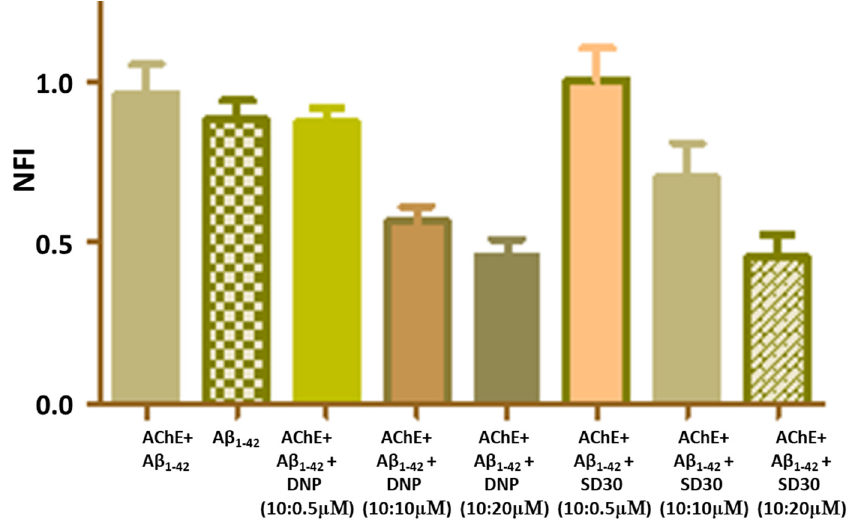
Figure 3. Effect of DNP, compound SD-30 on AChE induced A β aggregation: Donepezil (DNP) compound SD-30 showed a concentration-dependent decrease in the A β aggregation; AChE-induced the A β aggregation, and it is decreased by the DNP, compound SD-30.